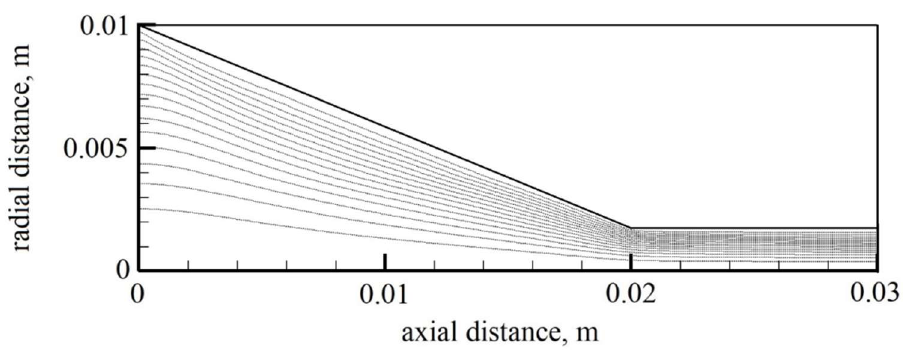
Figure 4. Flow field distribution inside the hollow tapered cylinder at the flow rate of 2 L/min.